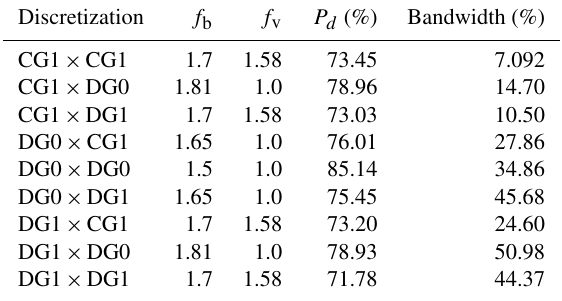
Table 4. Percentage of STREAM bandwidth and theoretical throughput achieved by the computation of integral I over 100 lay- ers on Sandy Bridge with 24 MPI processes.